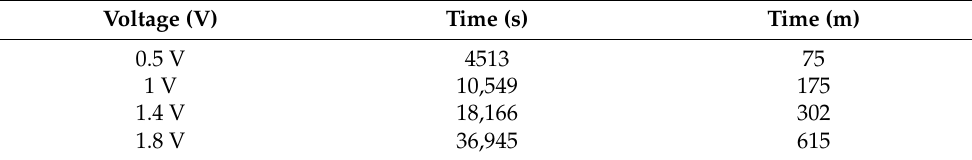
Figure 16. Waveforms of the charge time of the 10 F super capacitor with two piezoelectric devices. Table 3. 10 F super capacitor charge time with two piezoelectric devices.